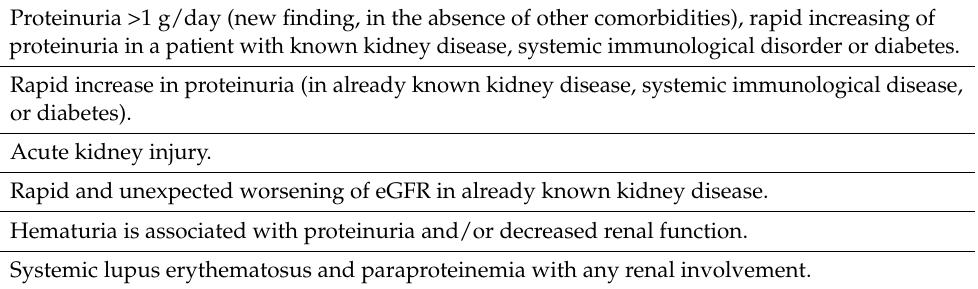
Table 1. Indications for performing renal biopsy